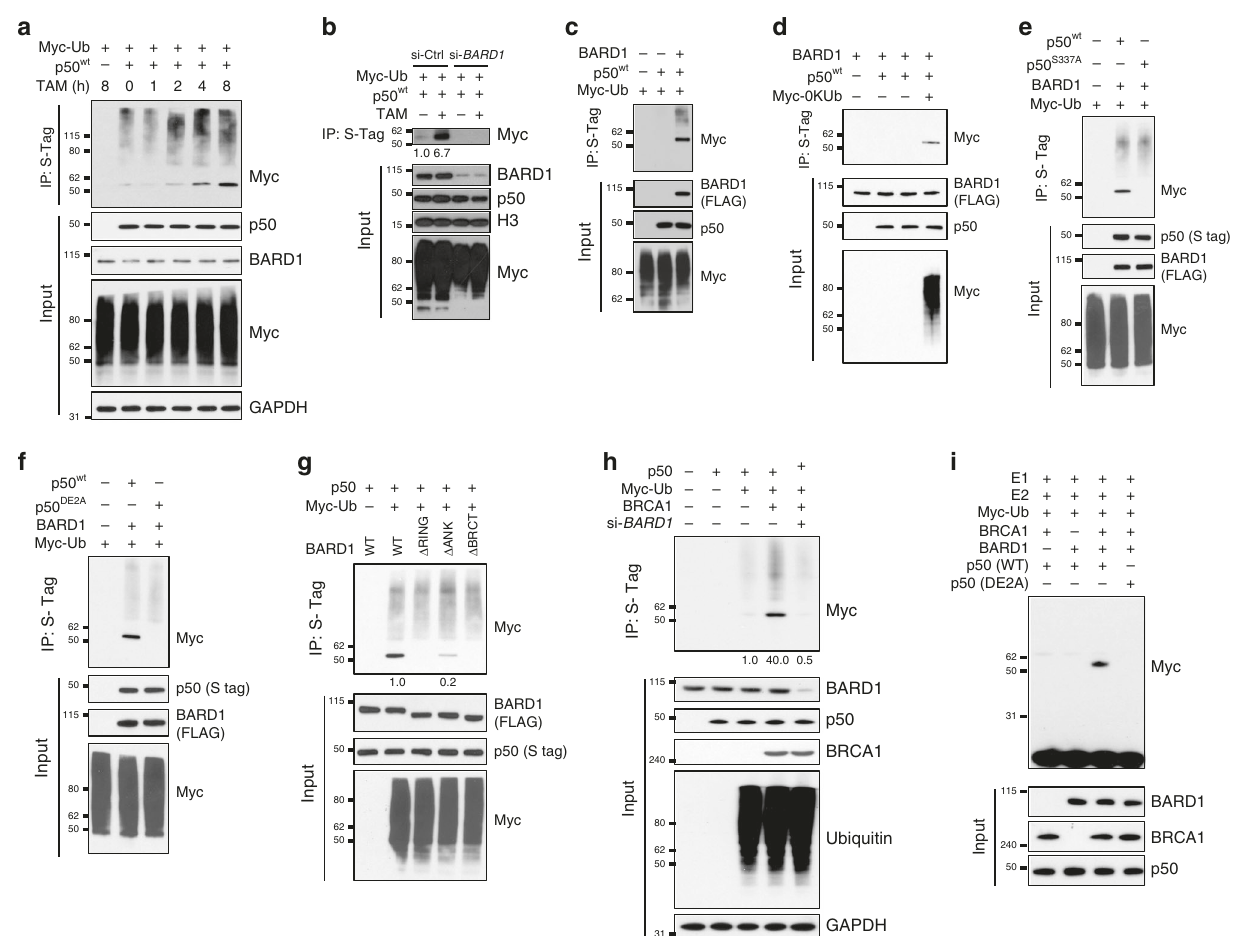
Fig. 3 BARD1 binding promotes p50 mono-ubiquitination. a Immunoblot (IB) in 293T cells expressing TopBP1 ER transfected with Myc-ubiquitin (Myc-Ub) and S-tag p50 wt treated with tamoxifen (TAM) for the indicated time. IP performed with S-agarose and IB with anti-Myc antibody. b Cells transfected as in A and si- BARD1 or si-control treated with TAM (4 h). Nuclear fractions were isolated and IP and IB performed as in A. H3, Histone H3. c Bard1 -null mouse cells transfected with Myc-Ub, S-tag p50 wt and FLAG-BARD1. IP with S-agarose and IB with anti-Myc antibody. d Bard1 -null cells transfected with FLAG- BARD1, S-tag p50 wt , and Myc-0KUb. IP with S-agarose and IB with anti-Myc antibody. e Bard1 -null cells transfected with FLAG-BARD1, Myc-Ub, S-tag p50 wt , or p50 S337A . IP performed with S-agarose and IB with anti-Myc antibody. f Bard1 -null cells transfected with FLAG-BARD1, Myc-Ub, and S-tag p50 wt or p50 DE2A . IP with S-agarose and IB with anti-Myc antibody. g 293T cells transfected with Myc-Ub, S-tag p50 wt , and FLAG-BARD1 wild type or the indicated BARD1 deletion mutants. IP with S-agarose and IB with anti-Myc antibody. h HCC1937 BRCA1 mutant breast cancer cells were transfected with S- tag p50 wt , Myc-Ub, HA-BRCA1, and si- BARD1 as indicated. IP with S-agarose and IB with anti-Myc antibody. i In vitro ubiquitination using the indicated 6HIS-p50 protein incubated with GST-FL-BARD1, recombinant BRCA1, and Myc-Ub in the presence of UBE1 (E1) and Ubc5c (E2). IB performed with the indicated antibodies. All blots are representative of at least two biologically independent experiments. Analysis of fold-change normalized to control lane shown below IB where